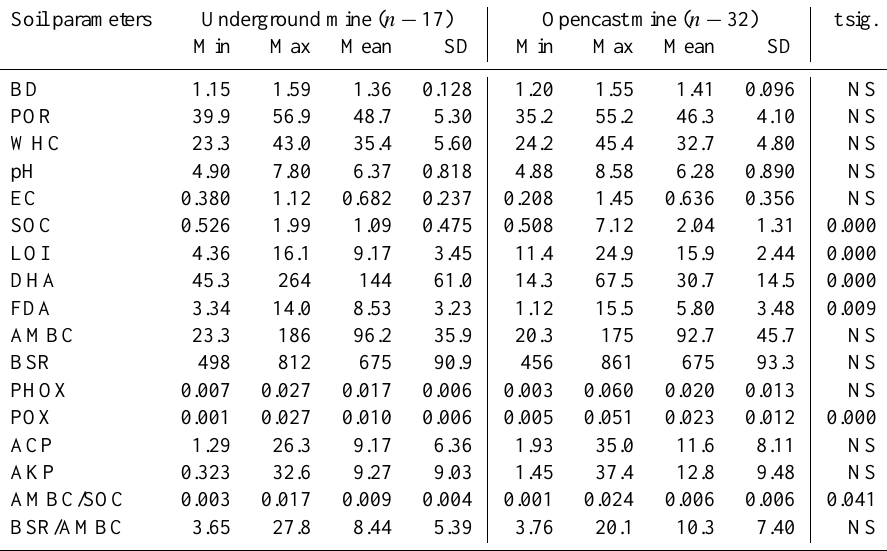
Table 1. Physical, chemical, and biological properties of soil in the opencast and underground mining site. Soil